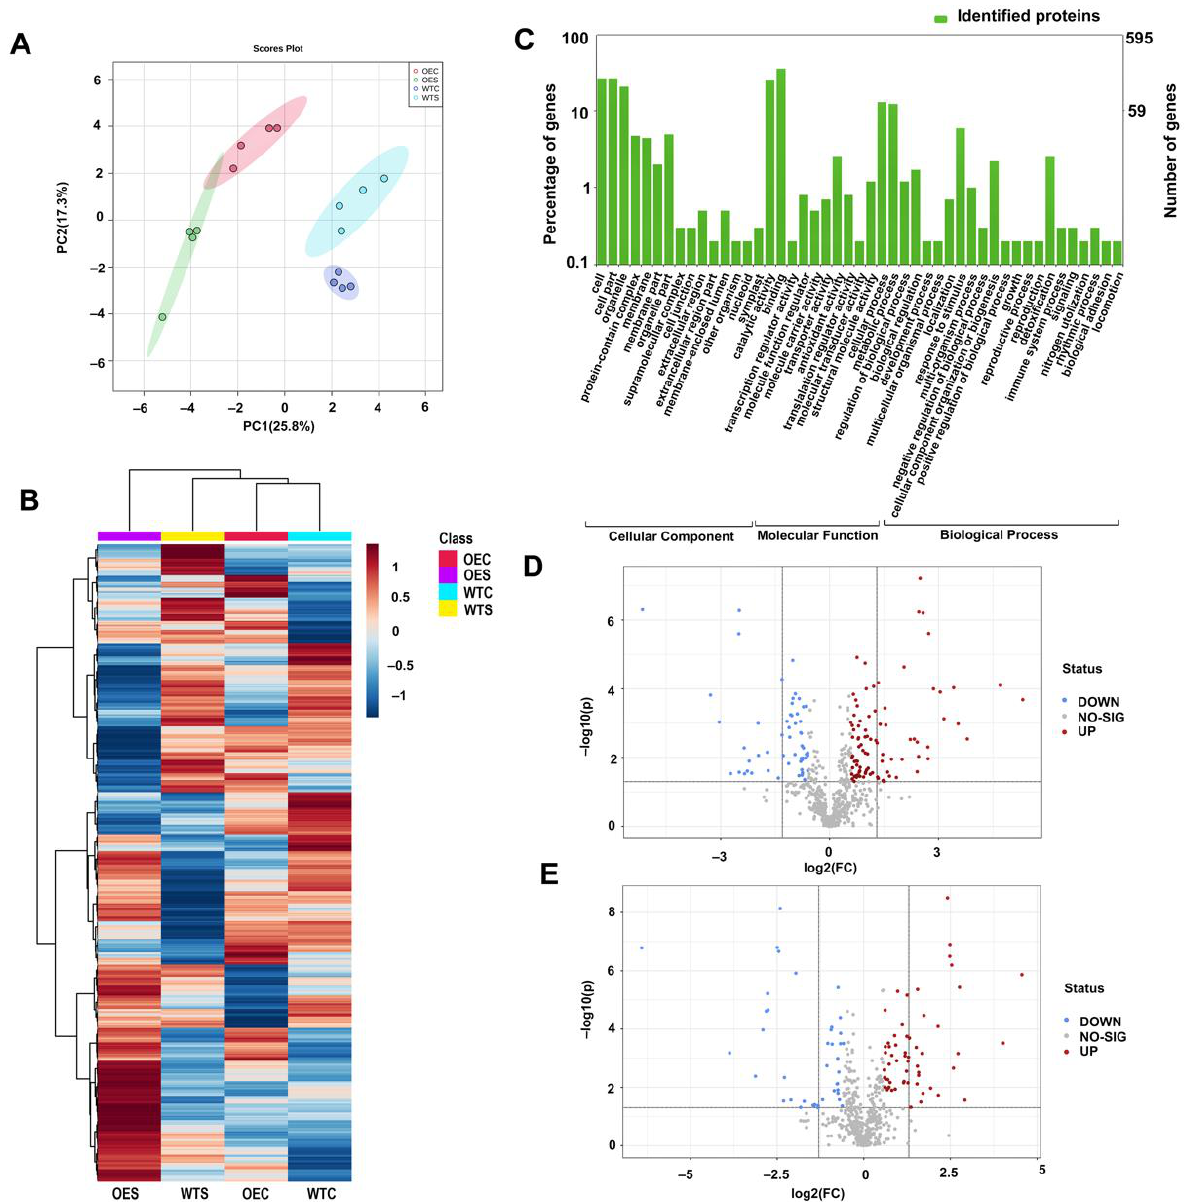
Figure 4. Proteomics analysis of OE and WT under control and salt stress conditions. ( A ) PCA analysis of proteomics data of OEC, WTC, OES, and WTS samples. Four biological replicates were included. ( B ) Clustering of the differential proteins in OEC, WTC, OES, and WTS. ( C ) GO enrichment of the identified proteins, including cellular component, molecular function, and biological process. ( D ) Significantly changed proteins in OE compared to WT under control conditions. ( E ) Significantly changed proteins in OE compared to WT after salt stress treatment.